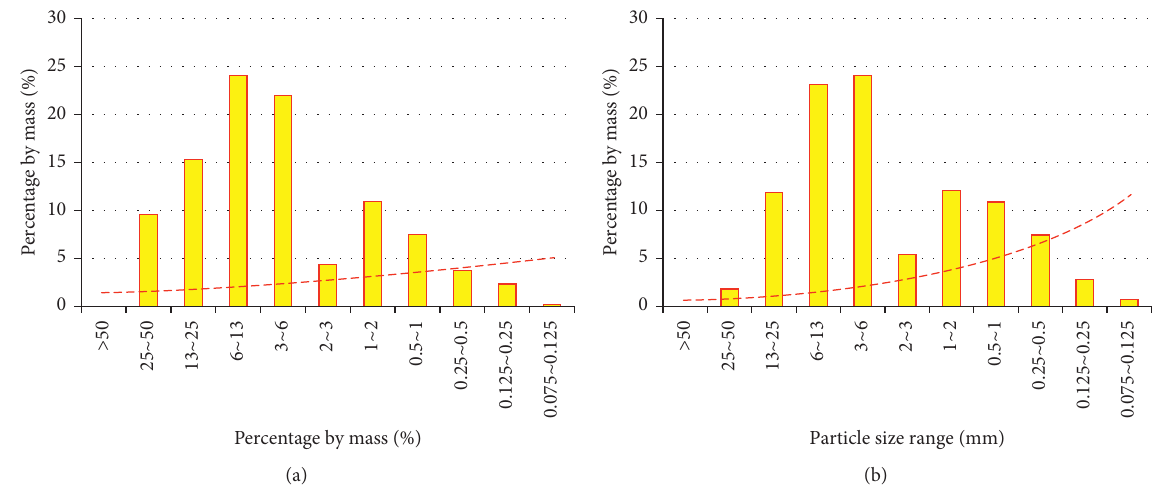
Figure 3: Distribution laws of the particle sizes of the soft coal in the different coal seams. (a) Soft coal in the No. 4 coal seam. (b) Soft coal in the No. 13 coal seam.